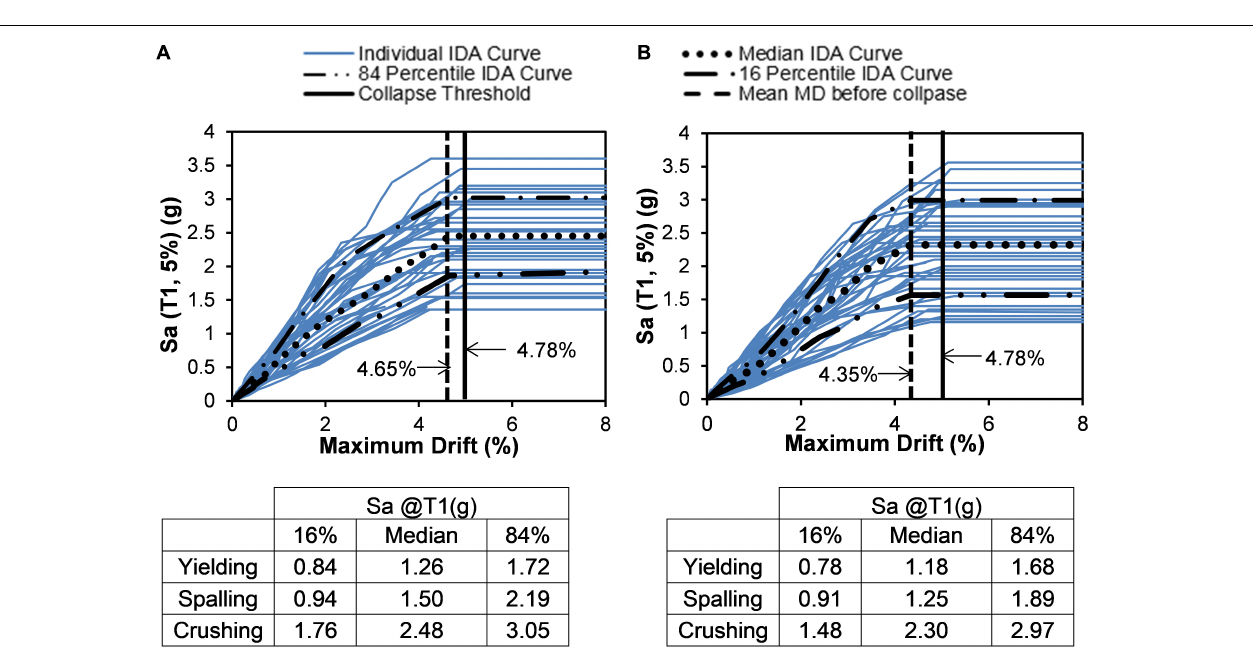
FIGURE 11 | IDA curves for maximum drift for reinforced concrete bridge bent with SMA at the bottom and top plastic hinge (SMA-B-T) (A) short duration motion (B) long duration motion.